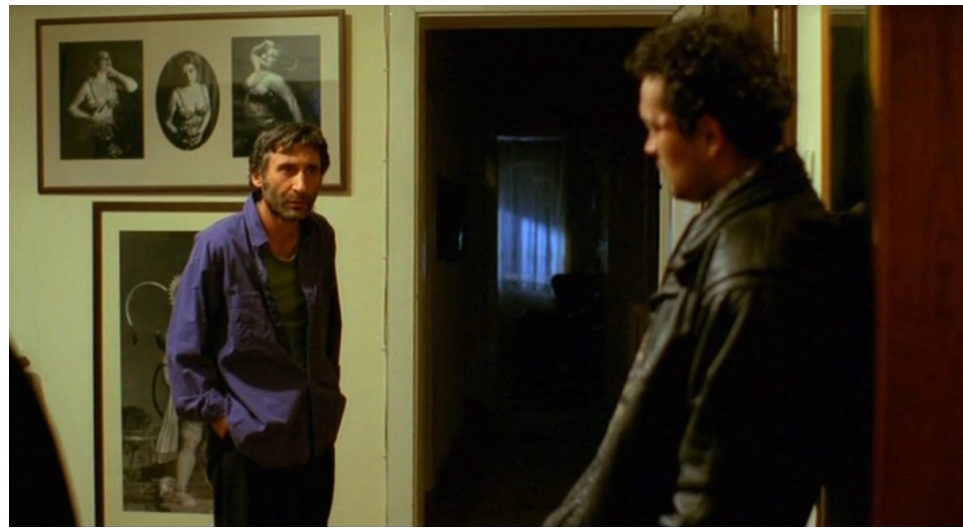
Figure 7: Nuri-Bilge Ceylan: